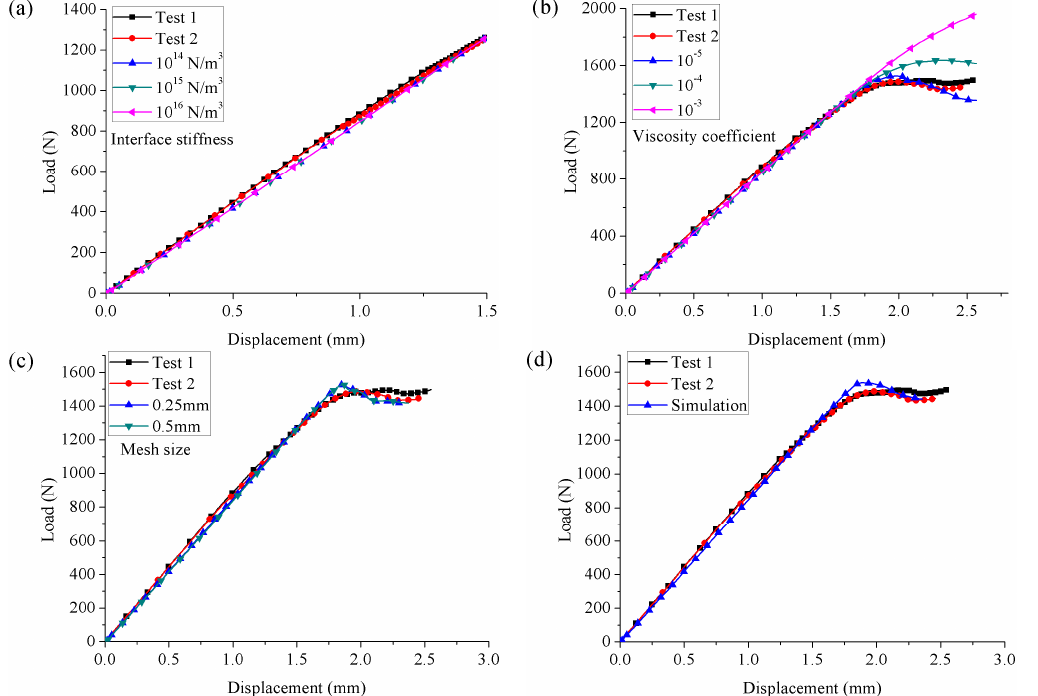
Figure 11. Influence of ( a ) interface stiffness, ( b ) viscosity coefficient, ( c ) mesh size on the predicted load–displacement response, and ( d ) numerical results of the ENF test at 130 °C.